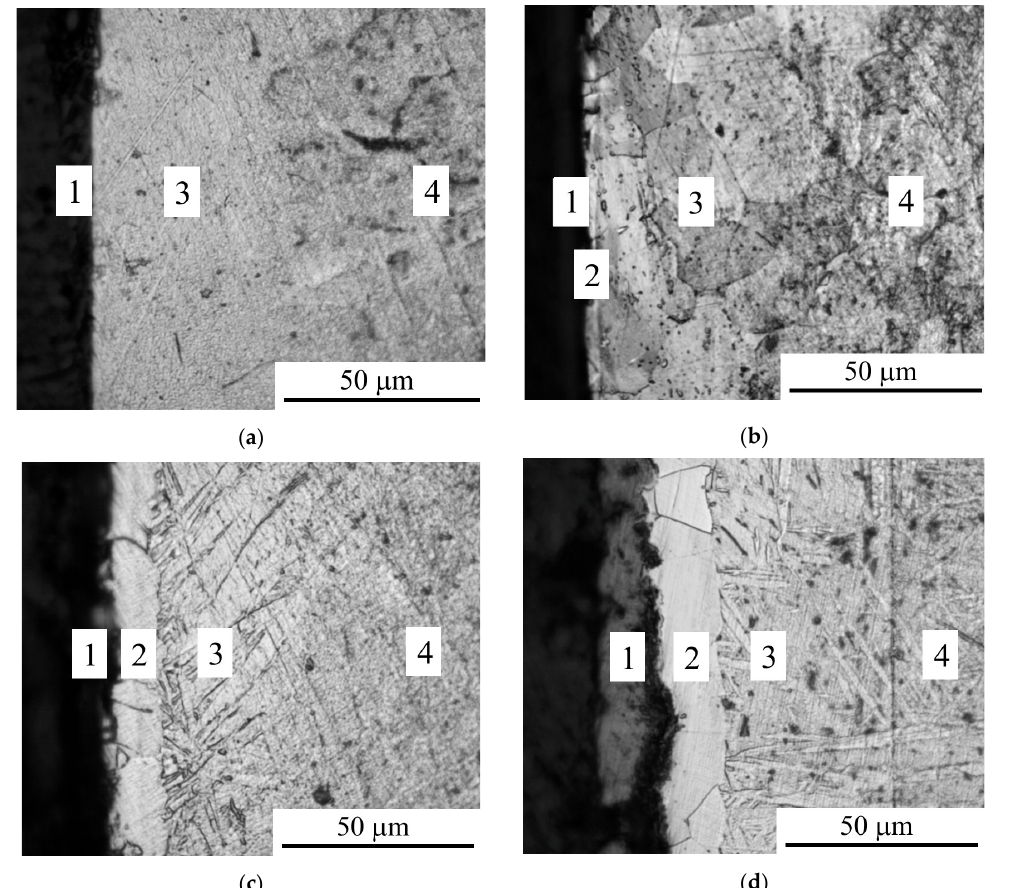
Figure 3. Microstructure of cross-section of the CP-Ti surface after anodic PENC at different treatment temperature: ( a ) 750 °C; ( b ) 800 °C; ( c ) 850 °C; ( d ) 900 °C. 1—oxide layer; 2—nitrided layer; 3—diffusion layer (N and C solid solution); 4—initial structure.